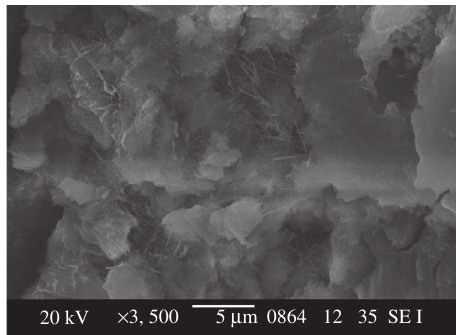
Figure 7 Flow ability of mixtures.